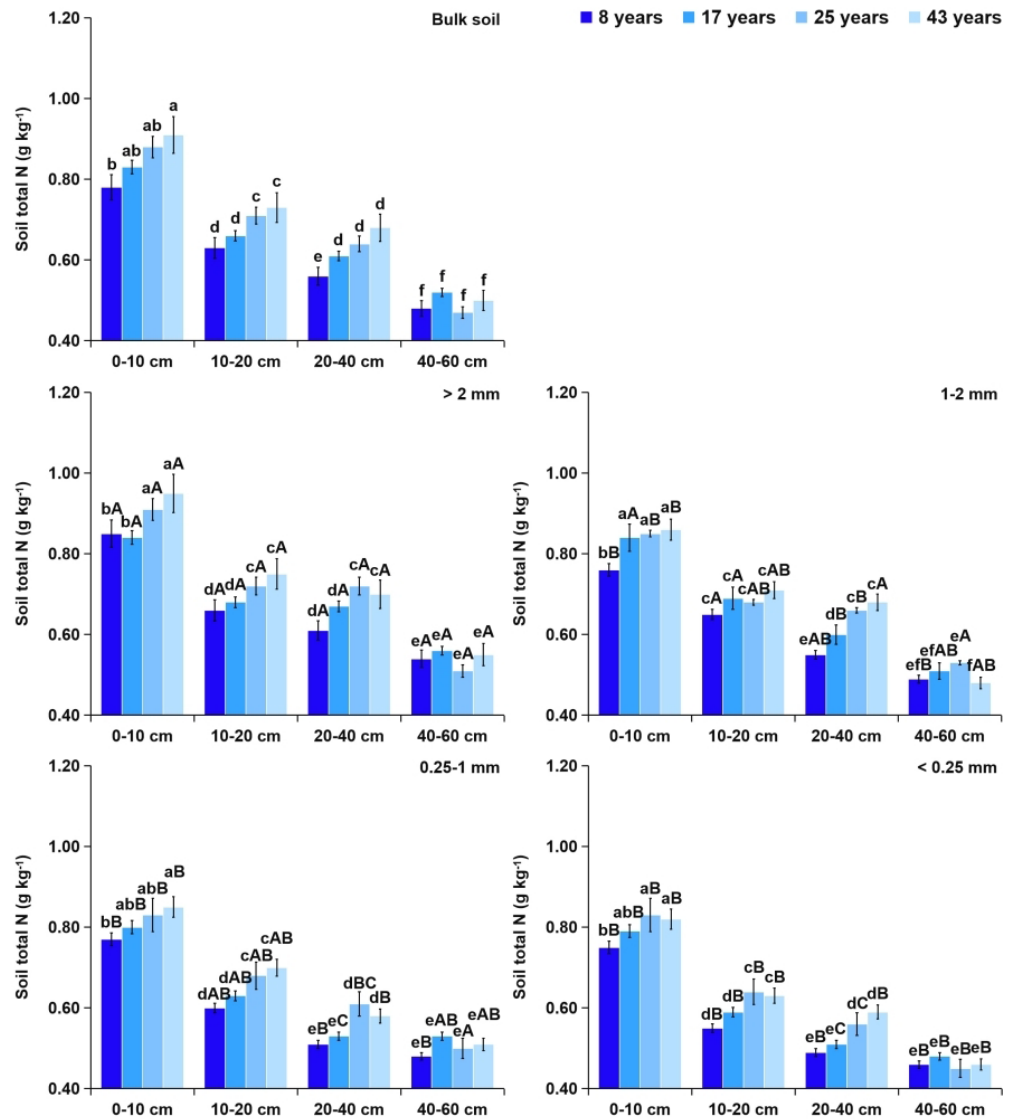
Figure 3. Effects of soil depth and tea plantation age on the total N content in bulk soil and different-sized aggregates. Data represent the mean of five replicates, and error bars represent the standard deviations. Means with the same lowercase letter are not significantly different ( p > 0 . 05) among different soil depths and tea plantation ages. Means with the same capital letter are not significantly different ( p > 0 . 05) among different-sized